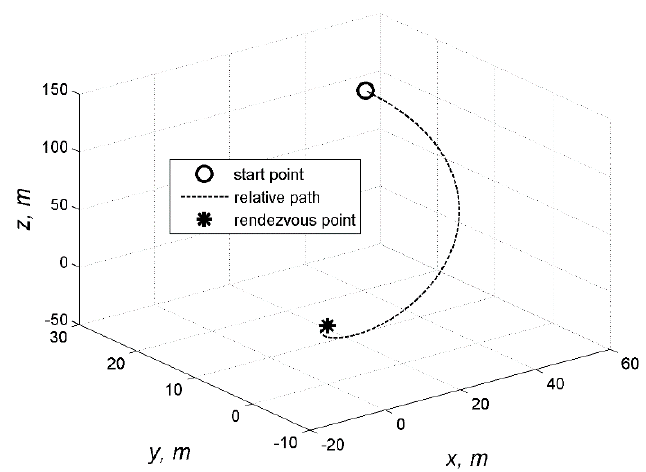
Figure 4. Relative motion of satellite to target.